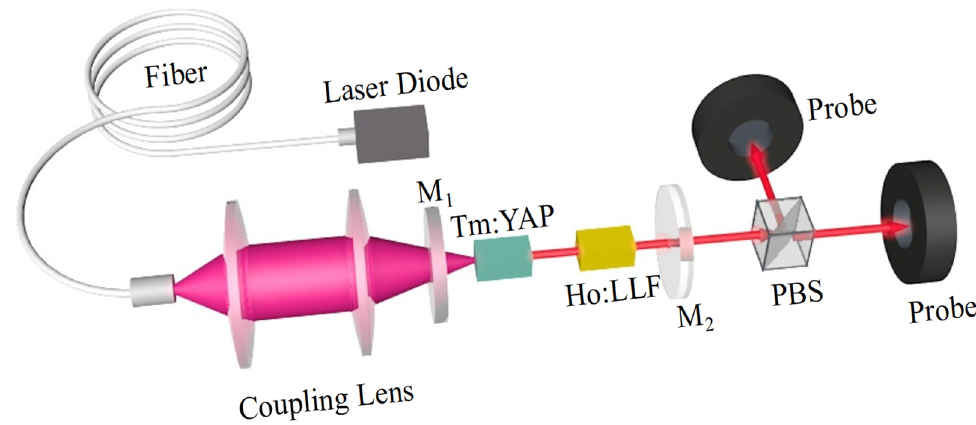
Figure 1. Experimental setup of the orthogonally polarized Ho:LLF laser.